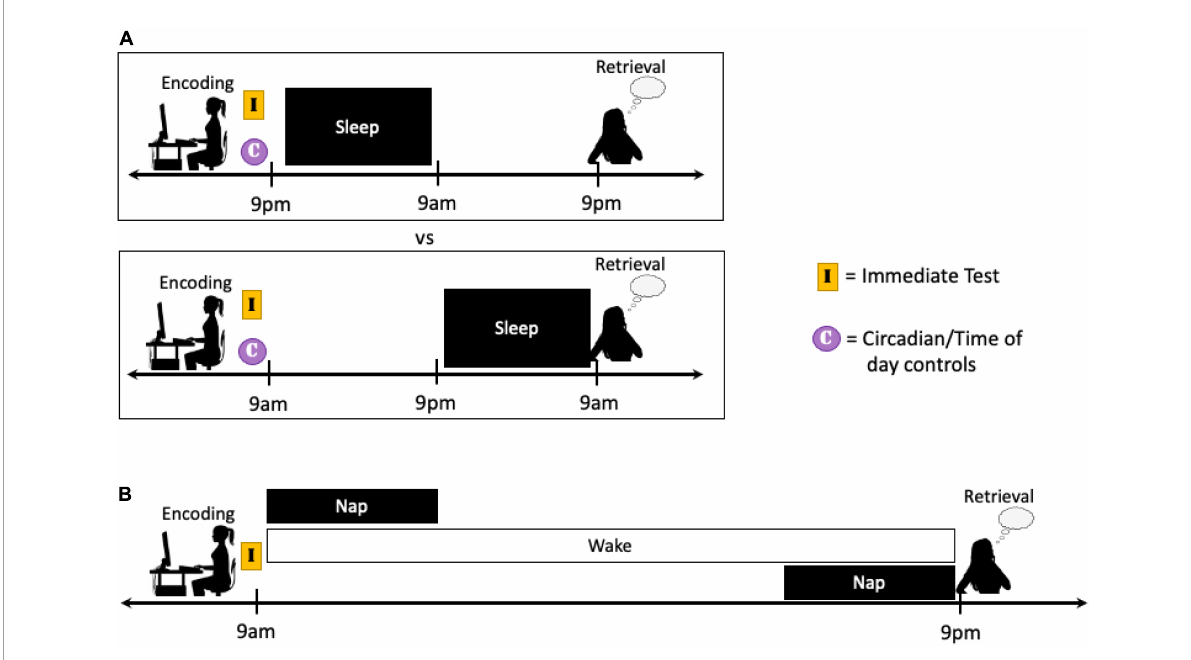
FIGURE5 Schematics of two potential study protocols designed to target the effects of sleep manipulation on the extended consolidation period. (A) Similar to the studies described in the text, longer protocols can be implemented so the sleep manipulation occurs after either a short or extended delay following encoding. In cases where encoding takes place at different times of day, immediate testing and/or circadian controls should be employed when possible to account for differences in sleep pressure and circadian phase. (B) Nap studies could also be utilized to better distinguish the point at which a memory transitions from the early to the extended consolidation stage. In these designs, a nap can occur either shortly following encoding or after an extended delay and performance can be compared to participants that remain awake the entire consolidation period. Modulating the placement of the extended nap in a systemic fashion could help determine when this transition occurs in the waking brain, or if sleep is necessary.